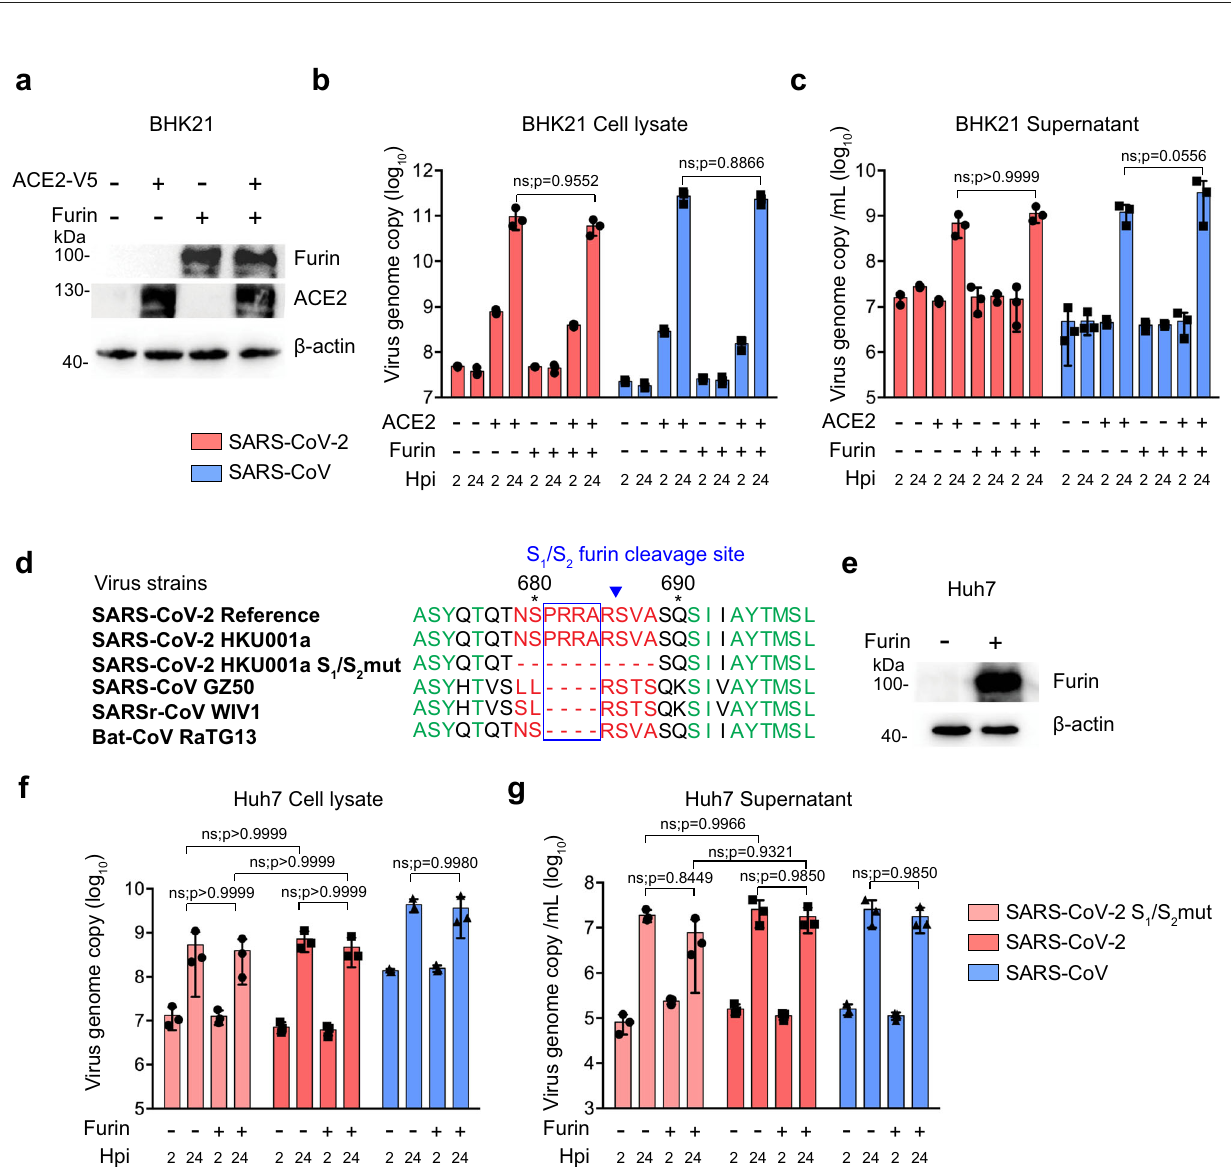
Fig. 4 Sialic acids present on ACE2 precluded perfect spike/ACE2-interaction. a Schematic of the N-linked and O-linked ACE2 glycosylation mutants. b Western blot of ACE2 glycosylation mutants overexpressed in BHK21 cells. c BHK21 cells were transfected with the ACE2 mutants for 24 h before inoculating the cells with SARS-CoV-2-S-pseudovirus. Pseudovirus entry was determined at 24 h post inoculation ( n = 3). d Entry of VSV-G-pseudovirus in BHK21 cells transfected with the ACE2 mutants ( n = 3). e BHK21 cells expressing the ACE2 mutants were infected with SARS-CoV-2. Virus replication in the cell lysate samples at 24hpi was evaluated with qRT-PCR ( n = 8 for EV, n = 12 for del N + O, n = 14 for other groups). f Virus replication in the supernatant samples at 24hpi was evaluated with qRT-PCR ( n = 8 for EV, n = 12 for N690Q, n = 14 for other groups). g The binding af fi nity between SARS- CoV-2-S RBD and human ACE2 was determined with SPR. h The binding af fi nity between SARS-CoV-2-S RBD and NA-pretreated human ACE2 was determined with SPR. Data represented mean and standard deviations from the indicated number of biological repeats. The experiments in b , g , and h were repeated three times independently with similar results. Statistical signi fi cance between groups was determined with one way-ANOVA. * represented p < 0.05 and ** represented p < 0.01. ns not signi fi cant, EV empty vector. Source data are provided as a Source Data fi le.